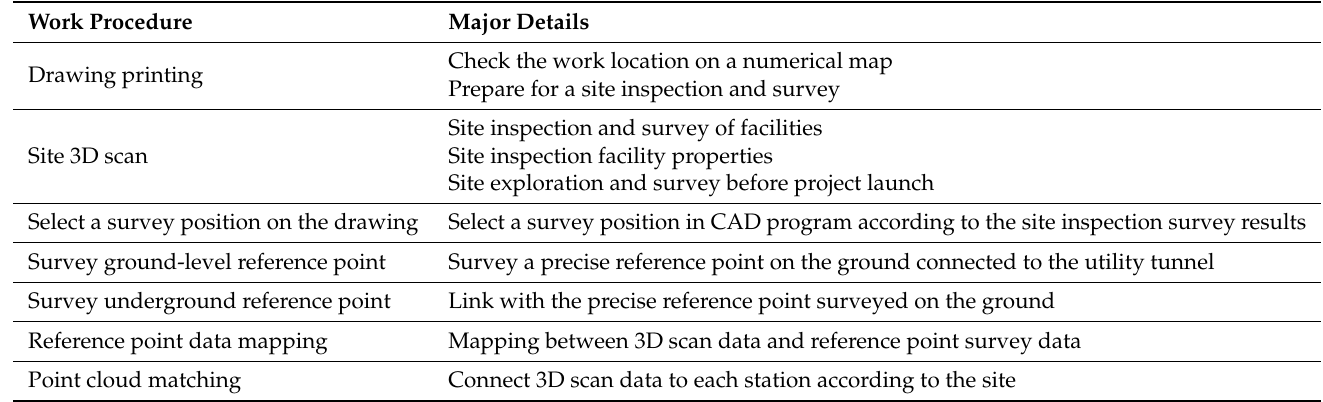
Table 4. Data acquisition procedure via LiDAR scanning and major